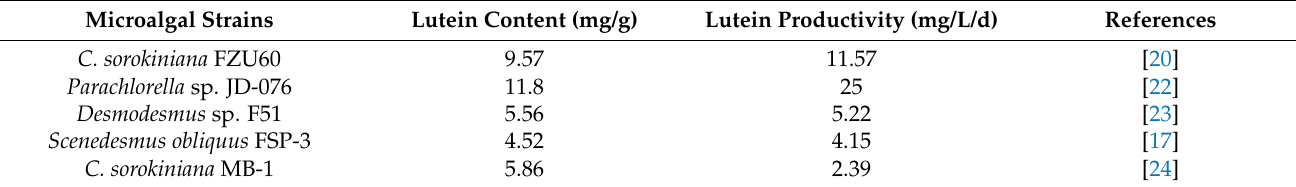
Table 1. Lutein content and productivity of microalgae strains under desirable cultivation conditions. Microalgal Strains Lutein Content (mg/g) Lutein Productivity